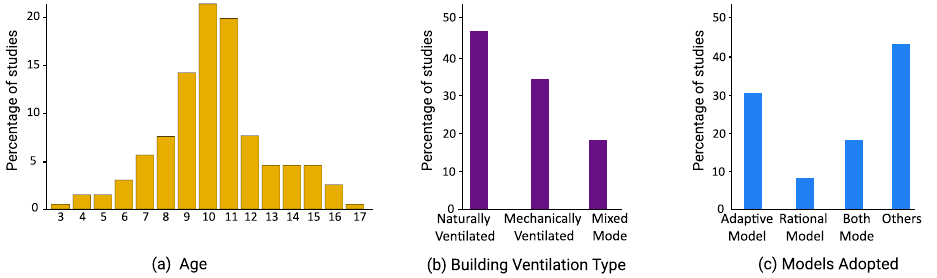
Figure 4. Distribution of studies across ( a ) Age, ( b ) Type of ventilation in buildings, and ( c ) Type of TC